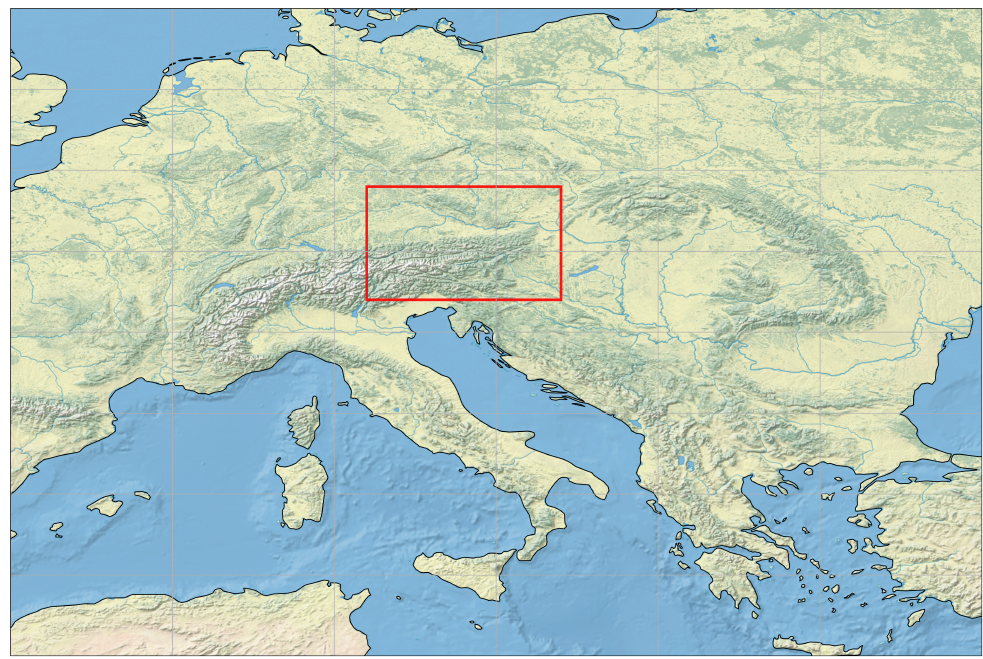
Figure 2. Lightning Dataset Region in Central Europe.